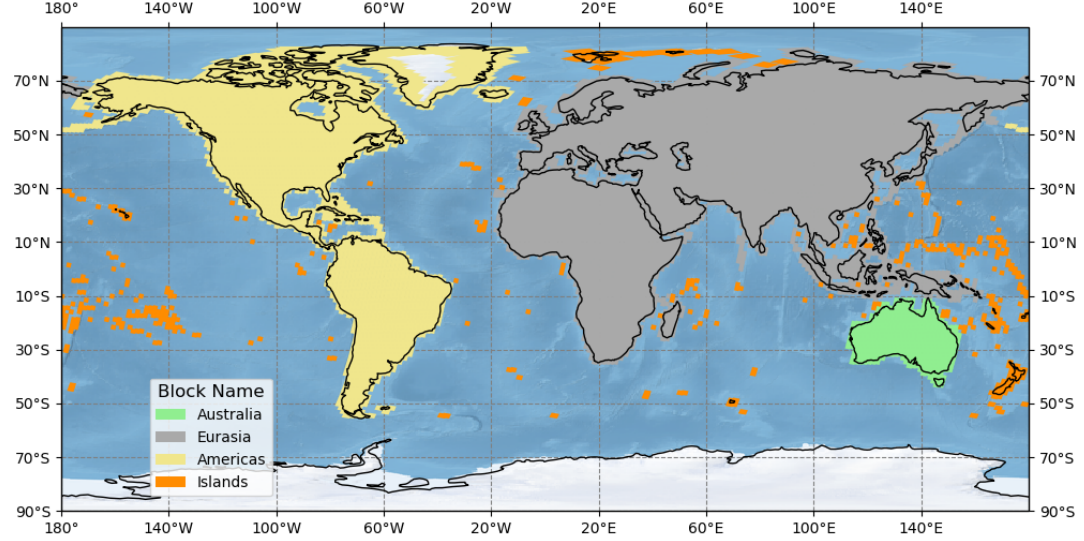
Figure 1. Map of triangulation blocks used in the bundle adjustment